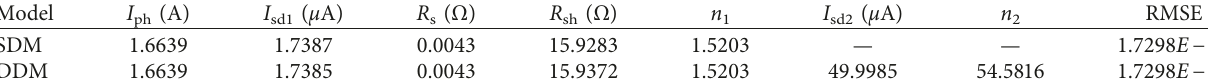
Table 10: Extracted value for the parameters of the STM6-40/36 module by SDO.